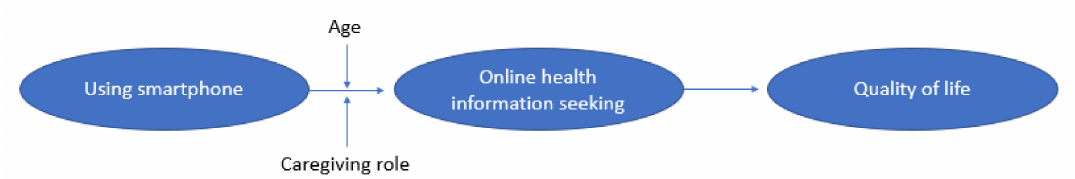
Figure 3. The research model of Zhang et al. [29]. In this model, health information consumers with different focuses were found to seek different online health information.